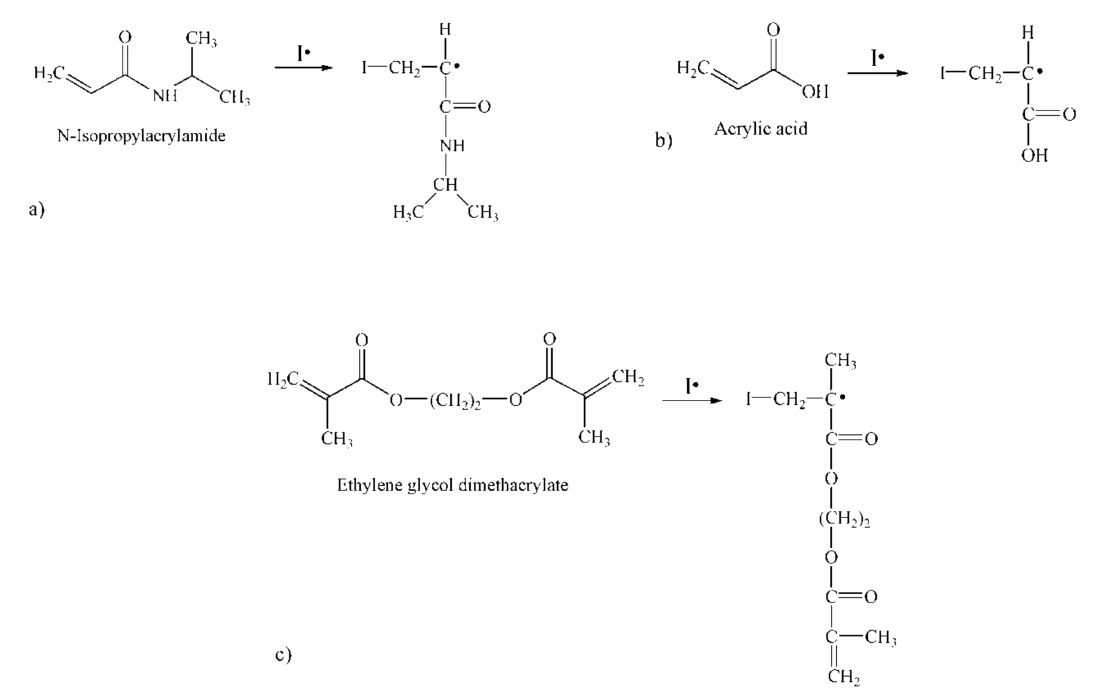
Figure 3. The formation of the radical species by reaction of the primary 2-cyano-2-propyl radical (I · ) with: ( a ) N - isopropylacrylamide, ( b ) acrylic acid and ( c ) ethylene glycol dimethacrylate.